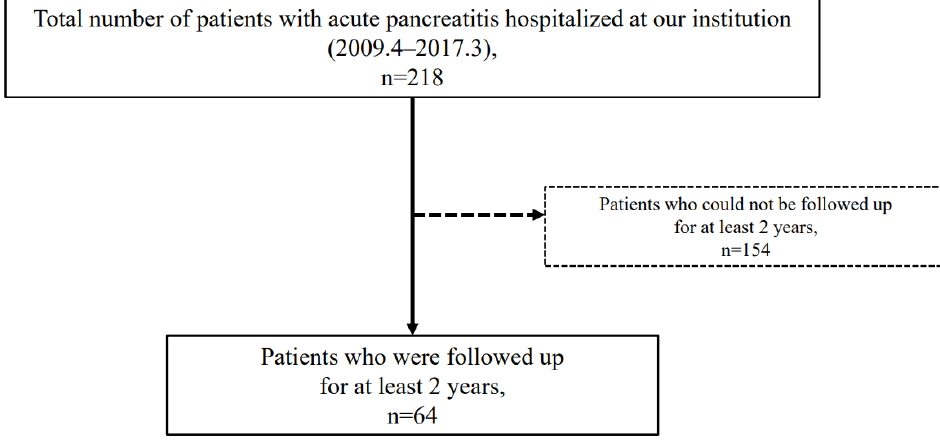
Figure 1. Flow diagram of this study.